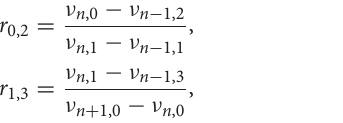
On a sidenote, we would like to emphasize the